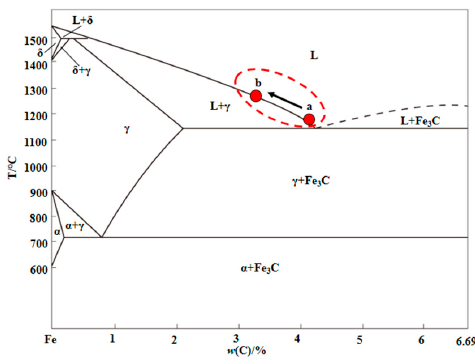
Figure 19. E ff ect of carbon content on theoretical melting point (a: low MgO; b: high Figure 19. Effect of carbon content on theoretical melting point ( a : low MgO; b : high MgO).